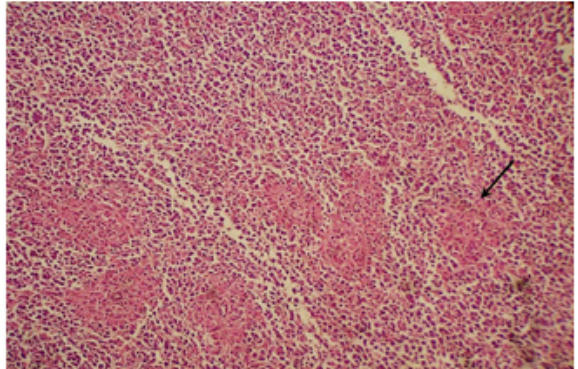
Figure 5: Photomicrograph of spleen showing neoplastic lymphocytic aggregates and dysplastic foci (arrow) (×